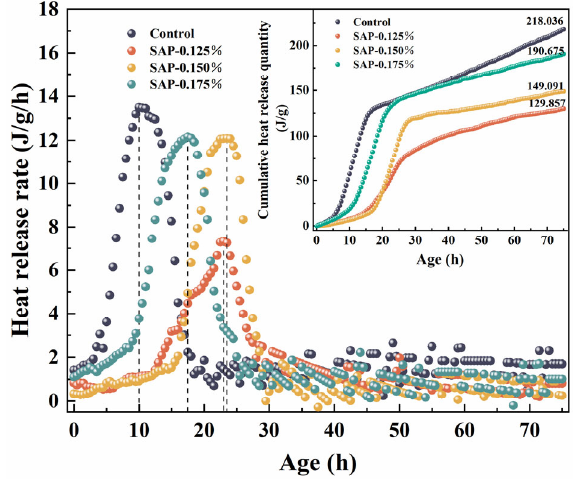
Figure 11. Hydration heat release curves: heat release rate and cumulative heat release quantity.